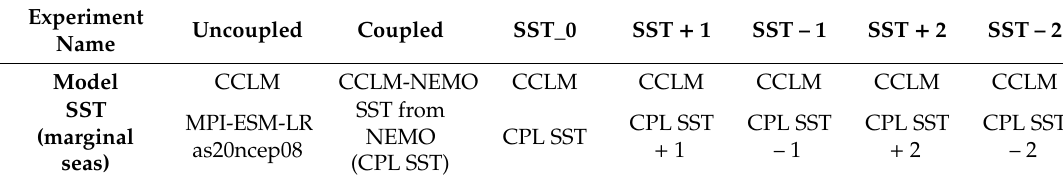
Table 1. Summary of the simulations compared in the sensitivity study. CCLM (Consortium for Small-Scale Modeling, Climate Limited-area Model), NEMO (Nucleus for European Modelling of the Ocean), CPL (coupled simulation,